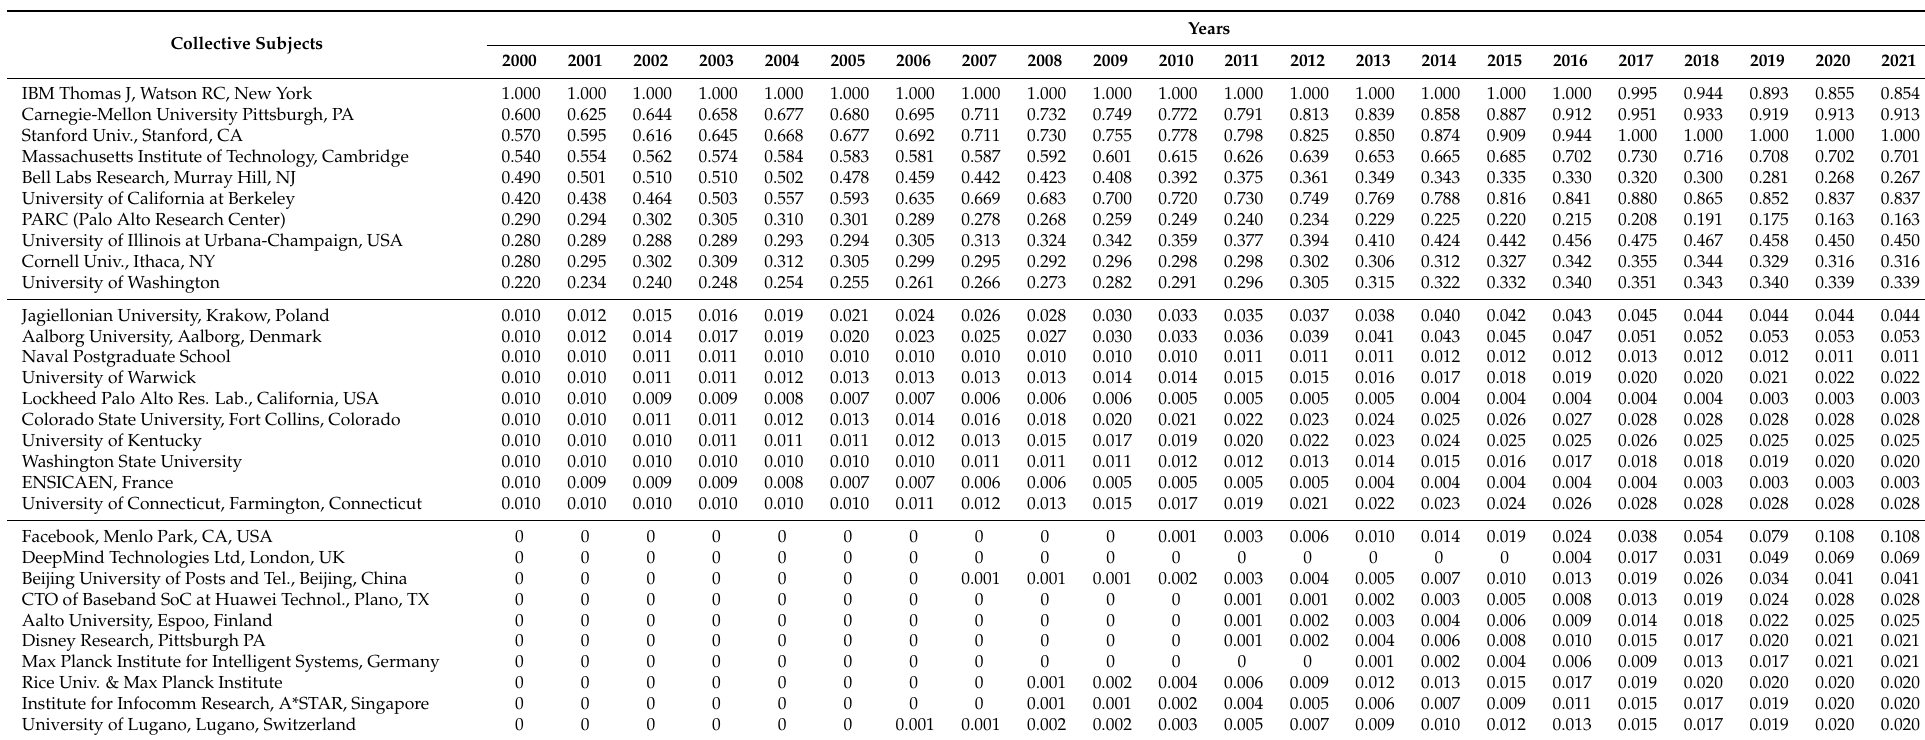
Table A1. Scientific productivity assessments of collective subjects calculated using the PR method.